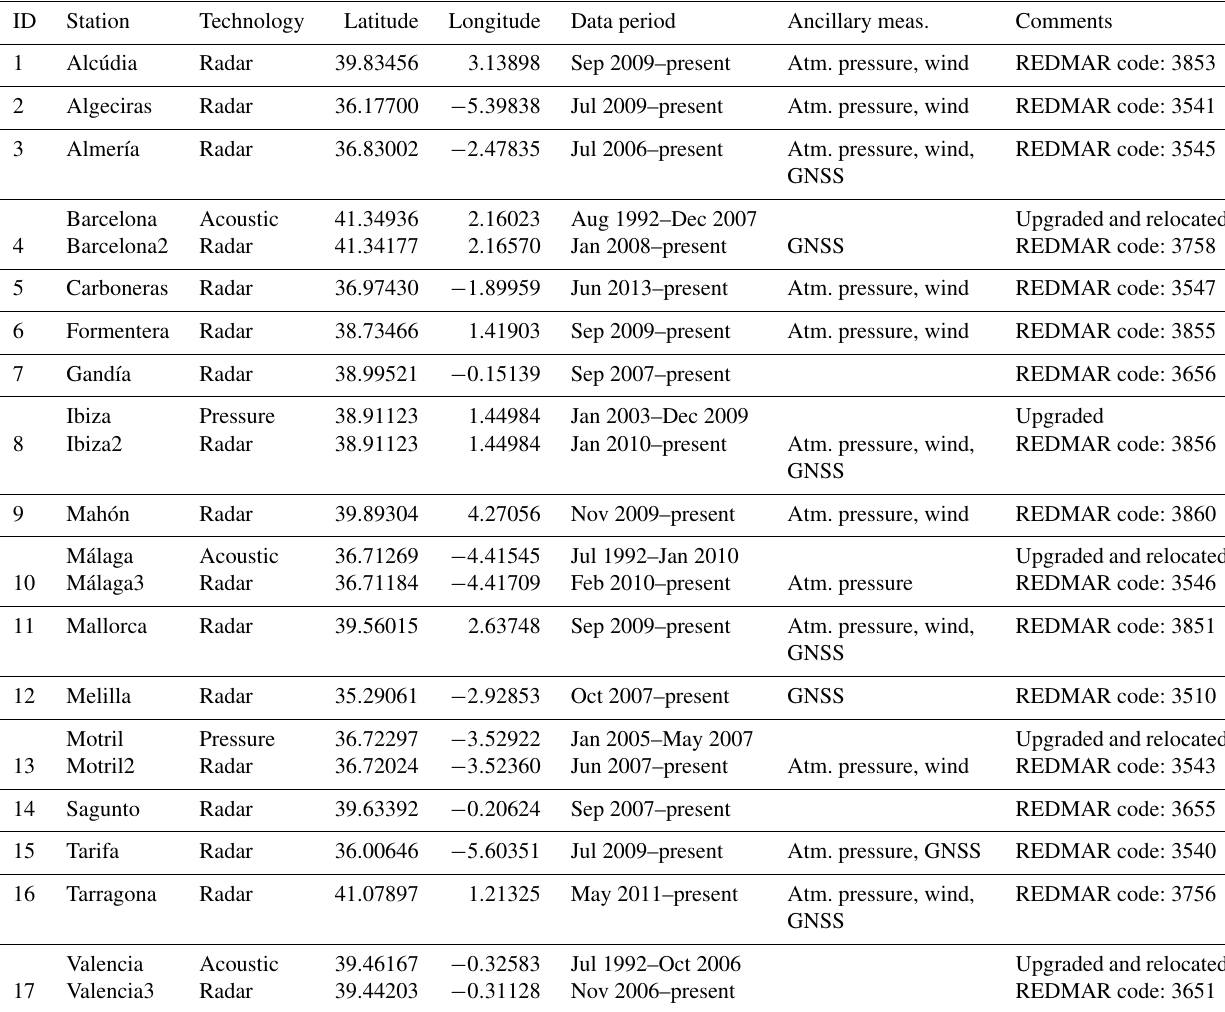
Table A1. Stations operated by Puertos del Estado, Spain (REDMAR network) and data availability. Data available at https://portus.puertos. es/?locale=en#/ (last access date: 18 June